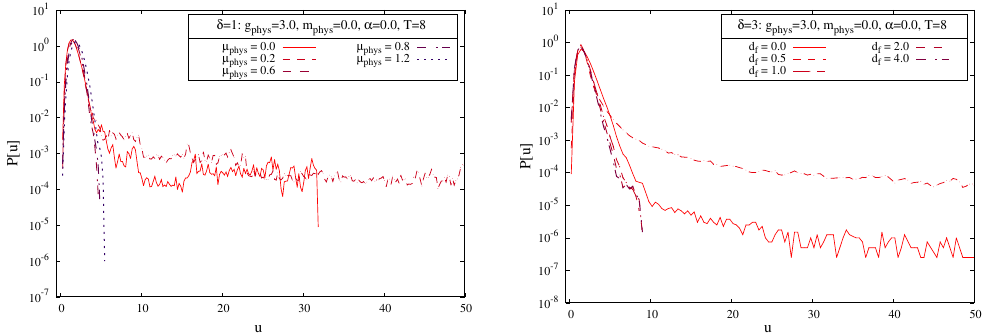
Figure 16 . The decay of the drift terms for the PT symmetric models with odd δ on T = 8 lattice. The parameters used were g phys = 3 , m phys = 0 , and α = 0 . 0 . (Left) The δ = 1 case. Simulations were performed for various µ phys values. (Right) The δ = 3 case. Simulations were performed for various values of the fermionic mass deformation parameter d f